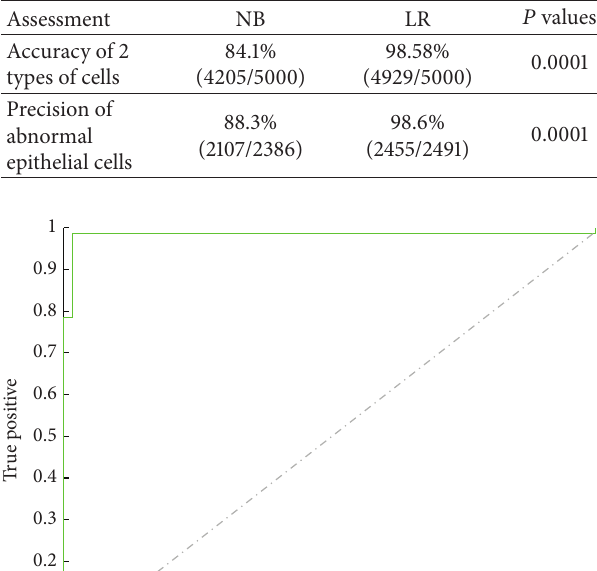
Figure 7: The histogram of the detection accuracy and the precision of each classifying system (KNN: 𝐾 -nearest